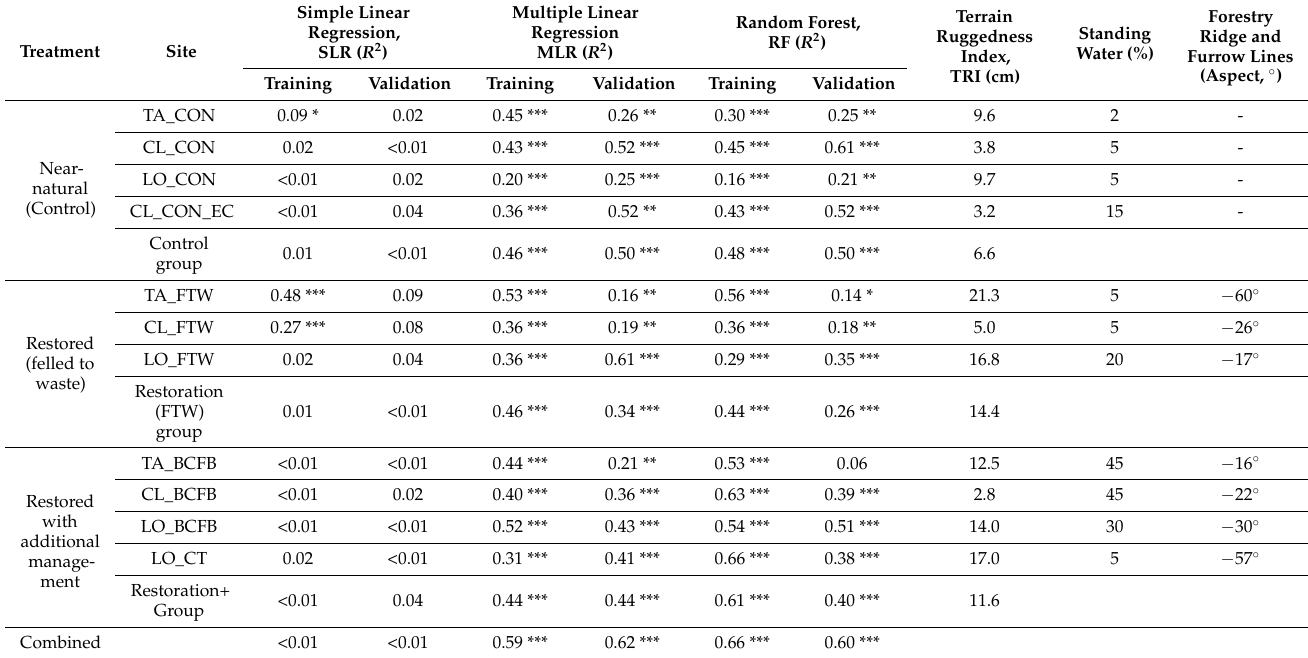
Table 4. SLR, MLR, and RF model performance using training (70%) and validation (30%) datasets, terrain ruggedness index (TRI), standing water presence (percentage of the total area), and forestry lines position (aspect in degrees, with True North being 0 ◦ ) of individual sites. *** Indicates a 0.001 significance level; ** indicates a 0.01 significance level; * indicates a 0.05 significance